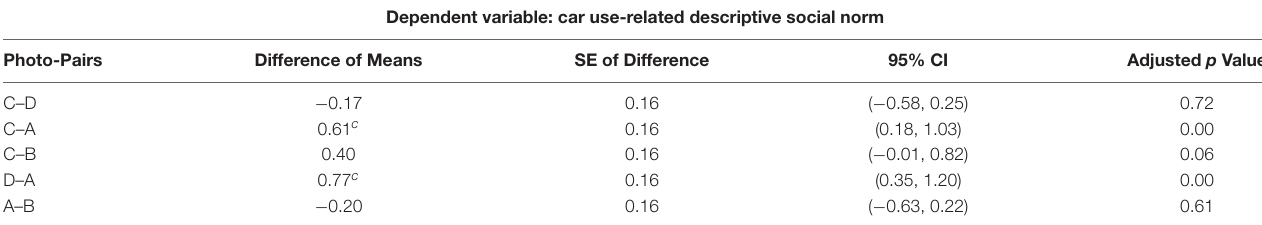
TABLE 5 | (Study 3) Tukey simultaneous tests for differences of means (ANOVA analyses, N = 725) between photos of Figure 4 . Dependent variable: car use-related descriptive social